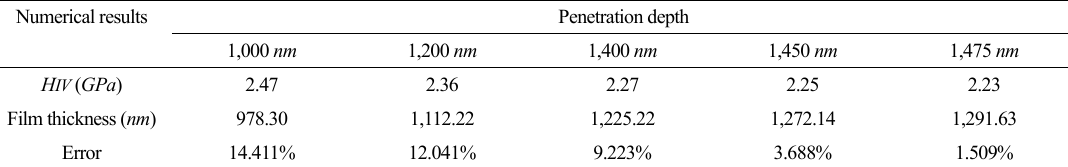
Table 7. Determination of film thickness using the convergence criterion described in the flow chart of Figure 4. Numerical